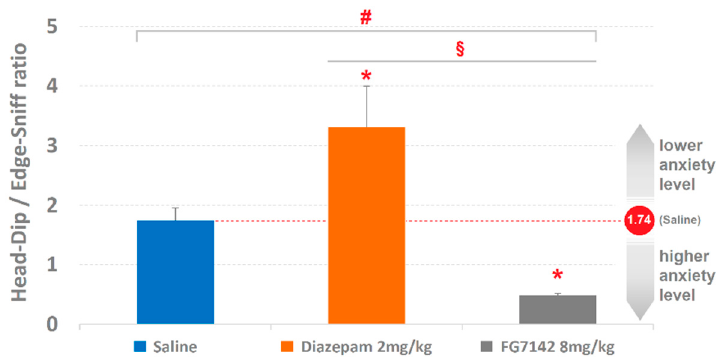
Figure 4. Effects of saline, diazepam 2 mg/kg and FG7142 8 mg/kg on the ratio between Head-Dip and Edge-Sniff. Data are represented as mean ± SE. # = statistically significant ( p < 0.05) ANOVA result; * = significant ( p < 0.05) difference of diazepam or FG7142 groups in comparison with saline group (Newman–Keuls post-hoc test for multiple comparisons); § = significant ( p < 0.05) difference between diazepam and FG7142 groups (Newman–Keuls post-hoc test for multiple comparisons). Data obtained from the analysis of three groups each encompassing 10 subjects. See Figure 1 for abbreviations.